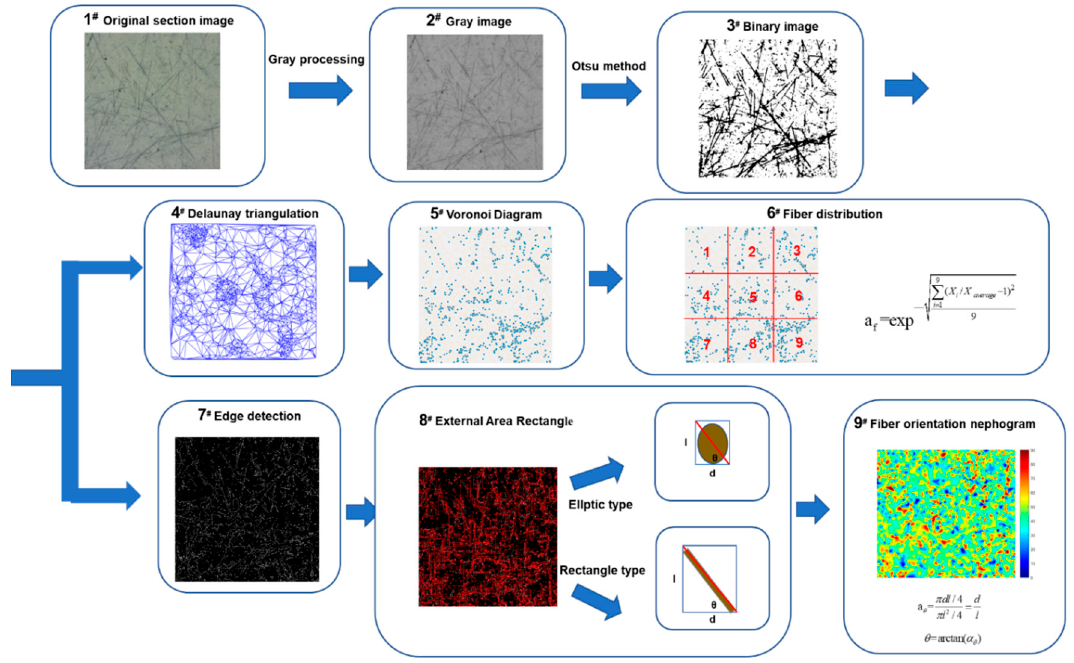
Figure 5. Flow chart of the digital image processing procedure.